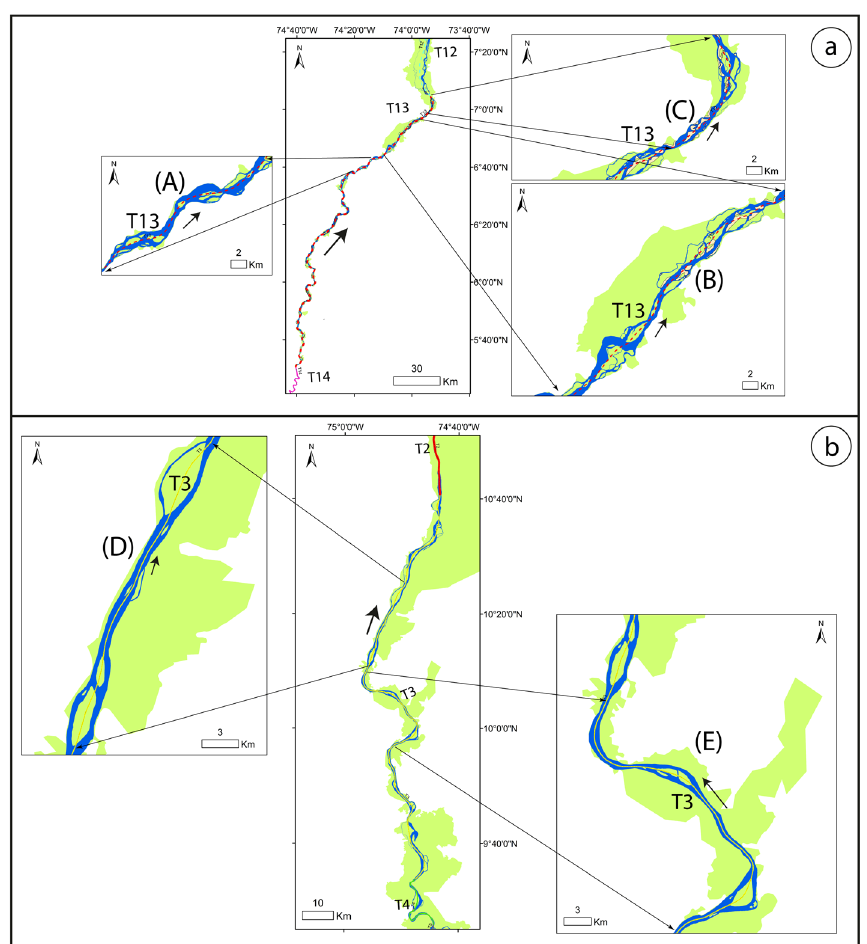
Figure 9. ( a ) Magdalena case study. T13 is an example of reach where the VB width criterion might call for further cuts (main stem scale 1:1,000,000; zoom’s scale 1:200,000; North on top); ( b ) Magdalena case study. Reach T3, an irrelevant anomaly linked to low DEM resolution in the VB determination (North on top).